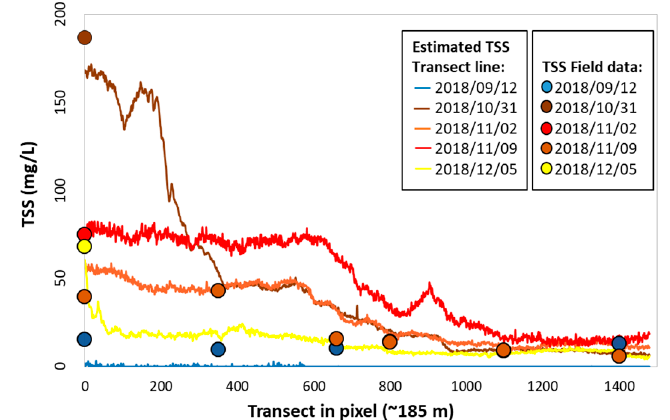
Figure 13. Measured and estimated TSS concentrations, using the Sequoia camera NIR band (model #1), extracted along the transect exhibited in Figure 10 for all survey dates in the Parano á reservoir.